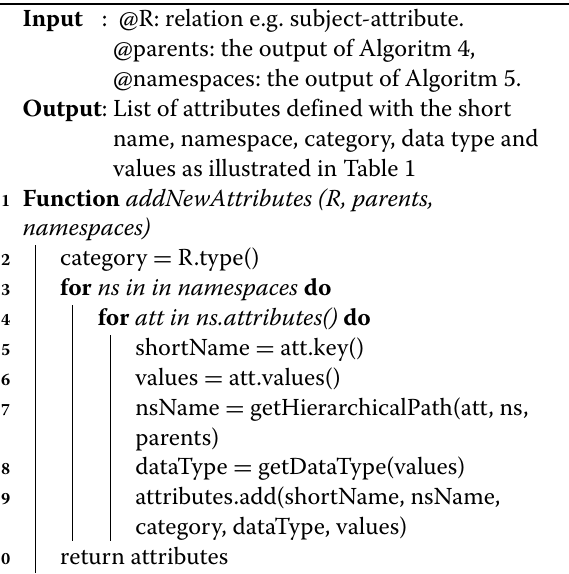
Algorithm 6: Define attributes of the